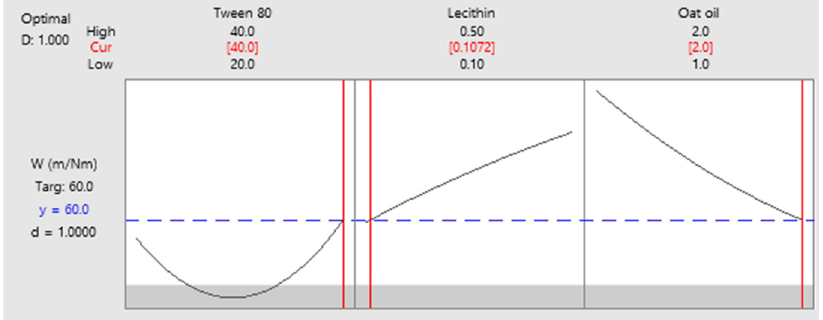
Figure 26. Predicted optimization plots for W response (Y 3 ) as function of three setting parameters: X 1— maximized, X 2— without constraints, and X 3— maximized, with a composite desirability of